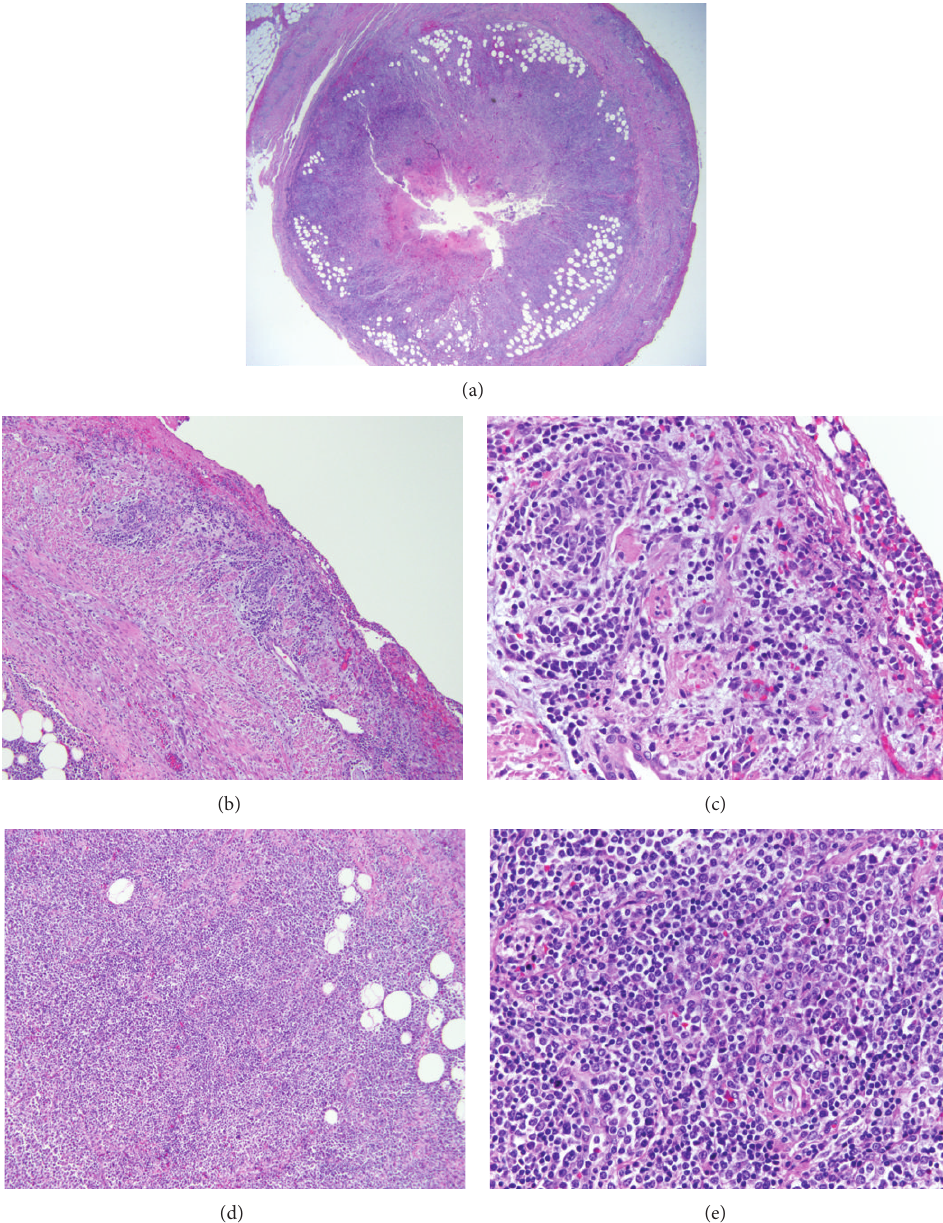
Figure3: (a)20x cross-sectionof theappendix specimen. (b)100x powered and(c) 200x powered appendiceal wall demonstrating transmural blastic infiltrates. (d) 100x powered and (e) 200x powered cross-section of appendix demonstrating leukemic